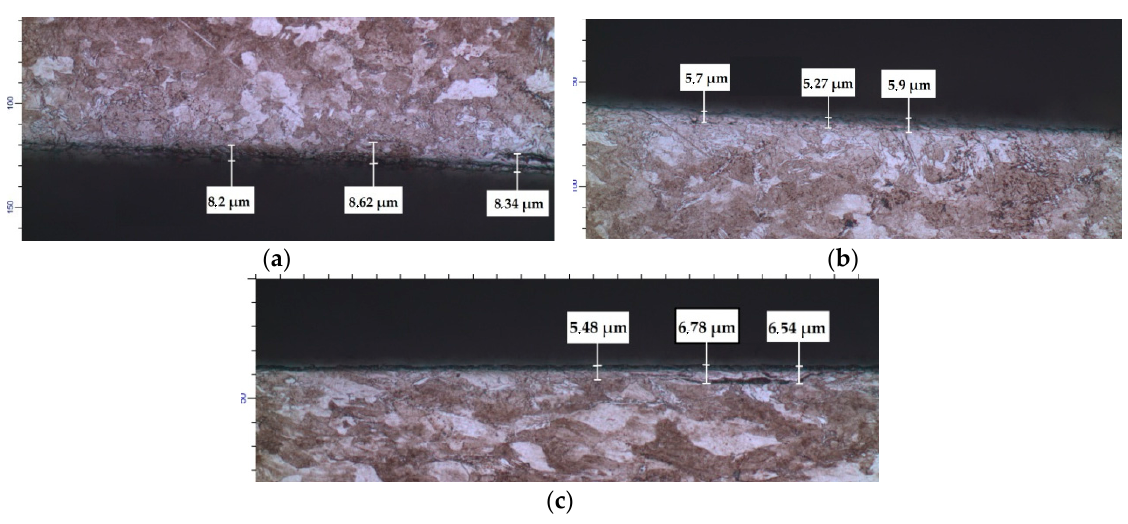
Figure 5. Thickness of the fine grain layers after each pass of the multipass drawing process through α = 4 ◦ dies: ( a ) the first pass, ( b ) the second pass, ( c ) the third pass.